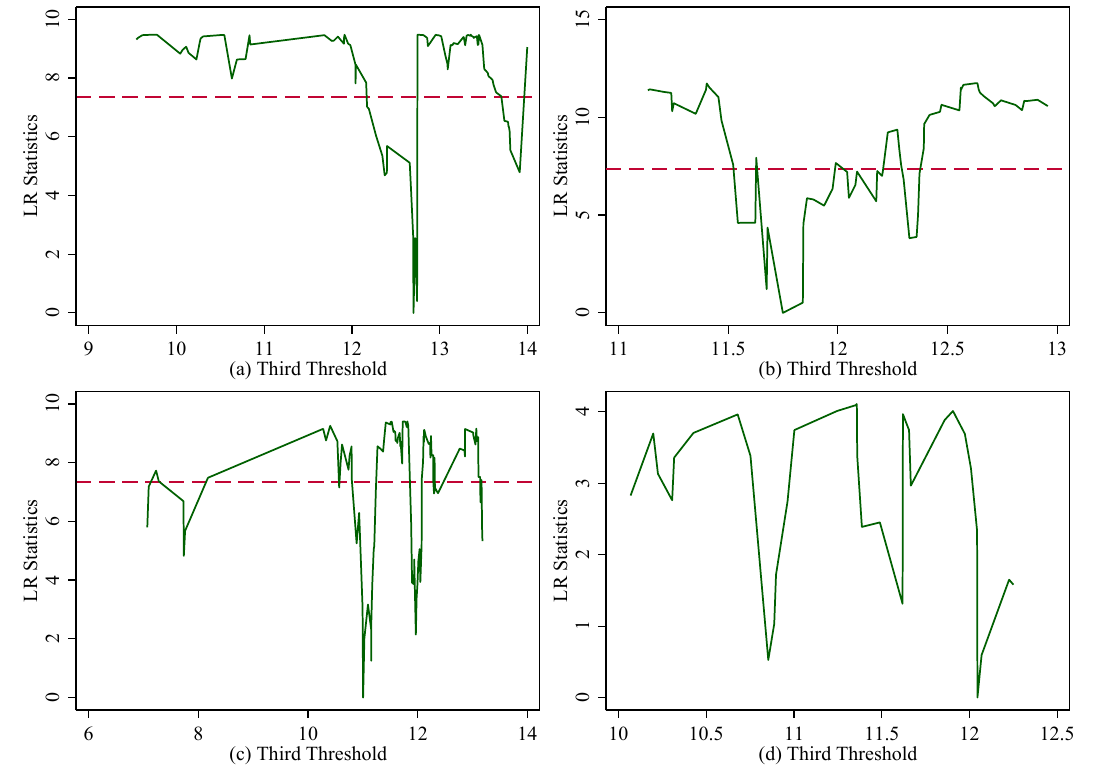
Figure 9. LR test results in different regions. Note: These graphs were created by the author using Stata 17.0. Notes: Figure ( a ) shows the LR test for the level of digital industrialization in the eastern region; Figure ( b ) shows the LR test for the level of digital industrialization in the central region; Figure ( c ) shows the LR test for the level of digital industrialization in the western region; Figure ( d ) shows the LR test for the level of digital industrialization in the northeastern region.